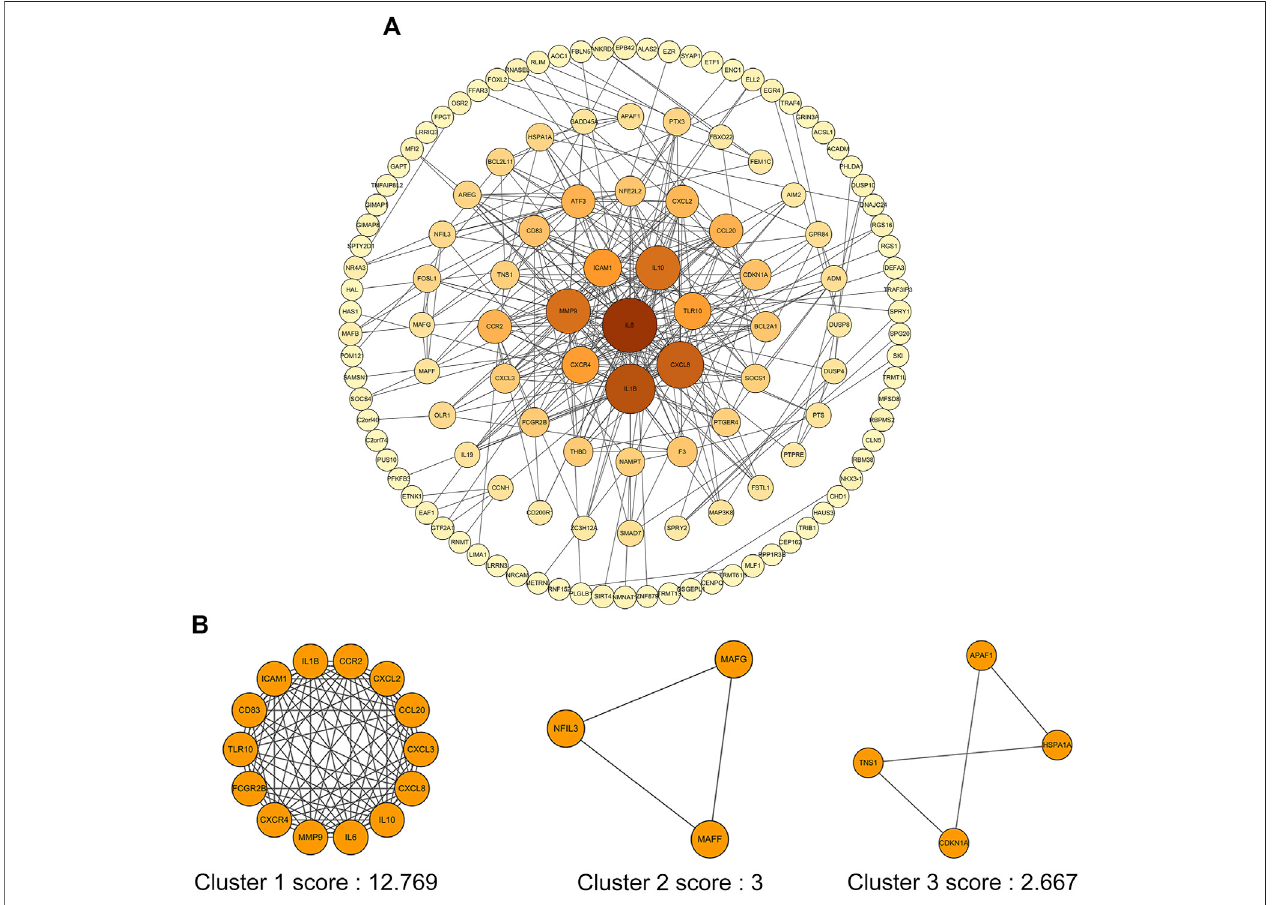
FIGURE 6 | PPI network of Co-DEGs and three cluster modules extracted by MCODE. (A) The interaction network between proteins coded by Co-DEGs was comprised of 130 nodes and 330 edges. Each node represents a protein, while each edge represents one protein – protein association. The size of the node represents the value of Degree, and the color of the node represents Neighborhood Connectivity. (B) Three cluster modules extracted by MCODE.